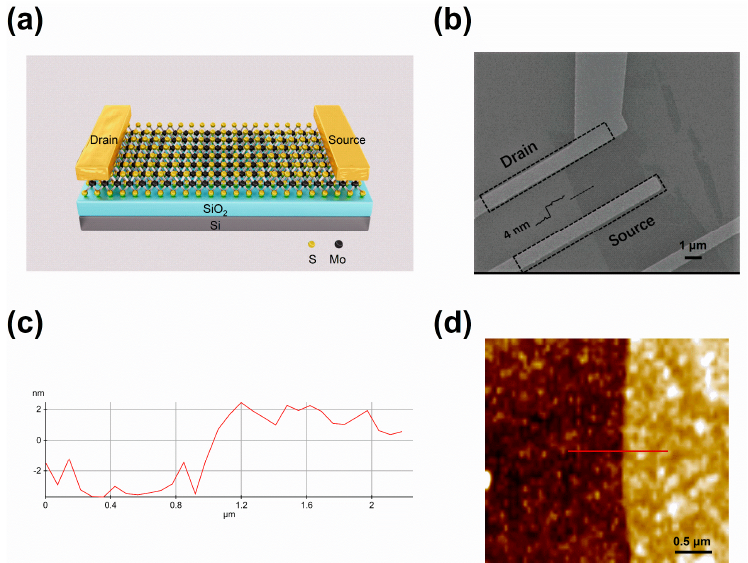
Figure 1. ( a ) Schematic of the fabricated MoS 2 FET. ( b ) SEM image of the MoS 2 FET. The drain and sources are indicated by dashed boxes. ( c ) and ( d ) AFM profile revealing the MoS 2 thickness along the red